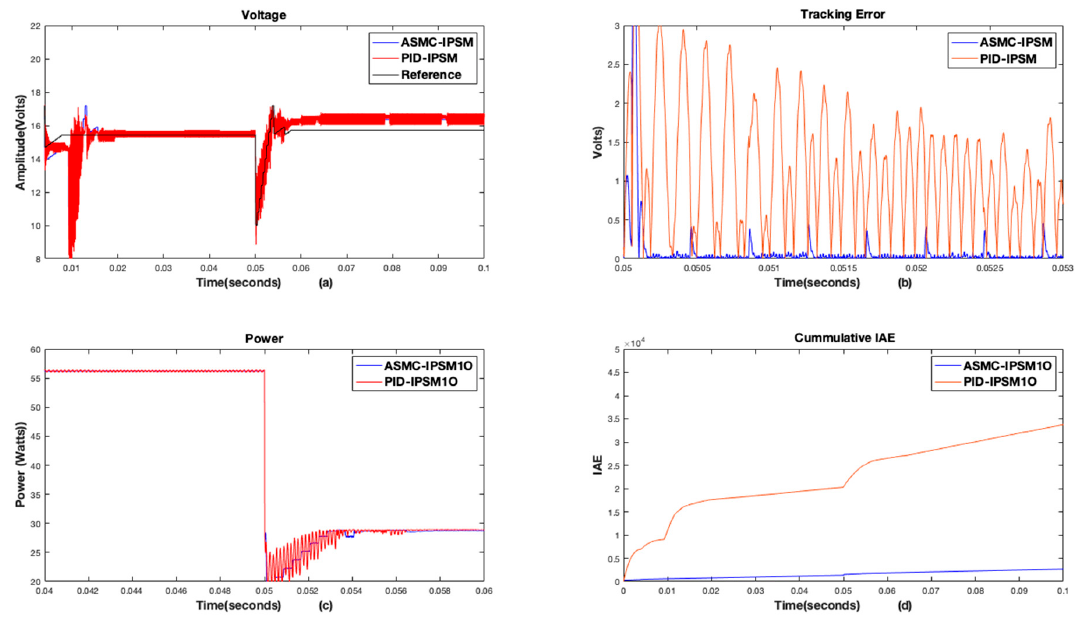
Figure 10. PID & ASMC based in IPSM MPPT with 10 particles ( a ) Profile of the PV panel voltage ( b ) Tracking response ( c ) Profile of the PV power extraction ( d ) IAE.